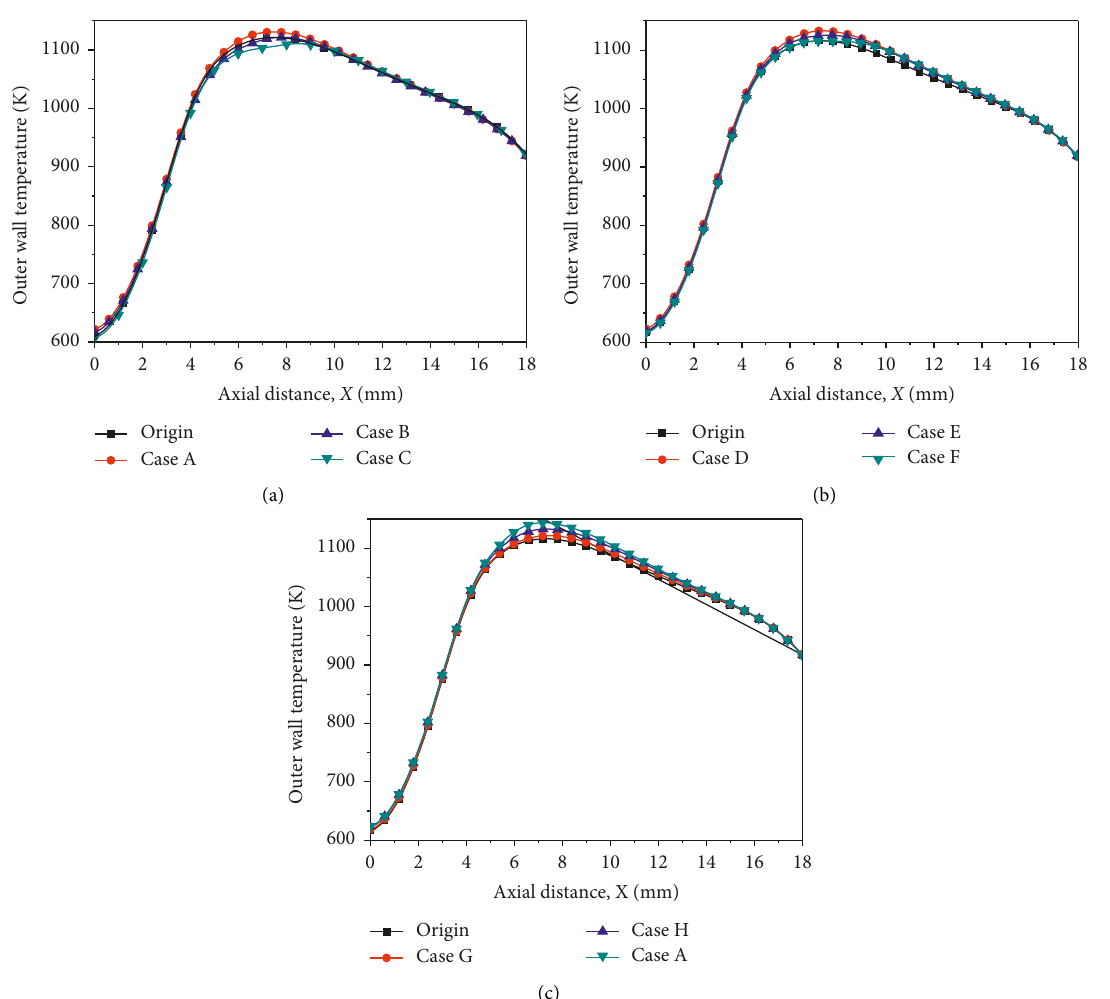
Figure 5: Outer wall temperature profiles for the original and improved combustor with inlet velocity equal to